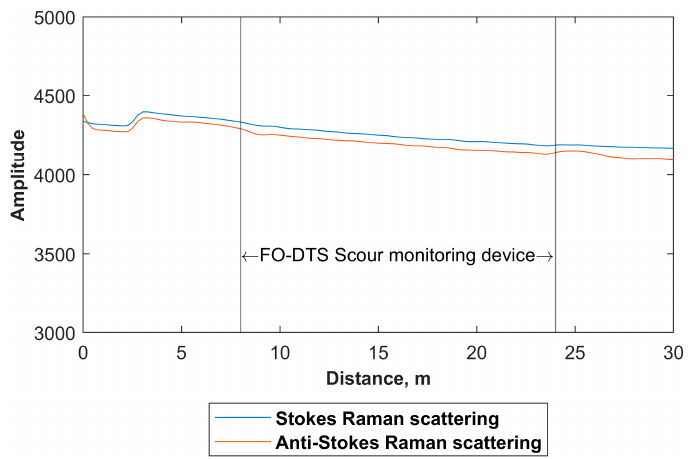
Figure 4. Example of the Stokes and anti-Stokes Raman scattering signals that were observed along the FO-DTS scour-monitoring device in a single measurement over a five second period before the start of the active heating.